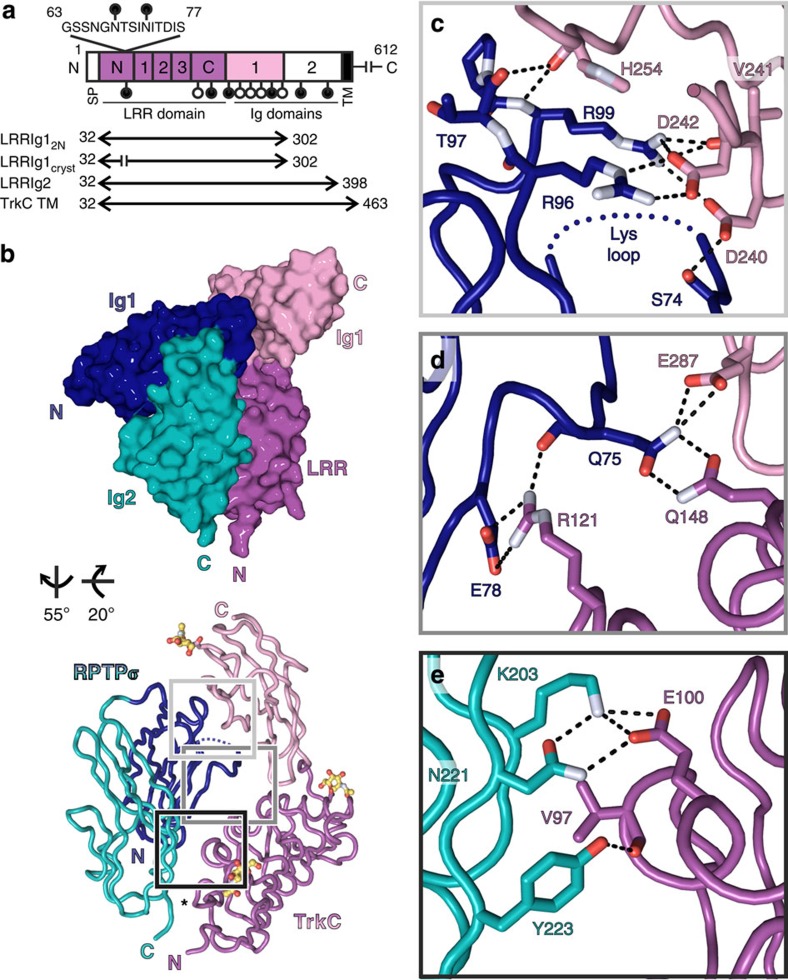
Trans-synaptic RPTPσ:TrkC complex crystal structure.(a) TrkCTK- (non-catalytic isoform) domain organization. LRR, leucine-rich repeat region (N, N-terminal cysteine-rich region; 1–3, leucine-rich repeats; C, C-terminal cysteine-rich region). Putative N-linked glycosylation sites, lollipops; filled lollipops remain in LRRIg1cryst construct. (b) Space-filled and tube representations of chicken RPTPσ Ig1–2:TrkC LRRIg1cryst crystal structure. N-linked glycans in atom representation. Disordered RPTPσ Lys-loop, blue dotted line; TrkC LRRIg1cryst amino-acid residue 62–78 junction, asterisk. (c–e) Detailed view of bonding interactions at RPTPσ:TrkC interface for binding sites 1–3. Corresponding electron density is illustrated in Supplementary Fig. 7. Potential electrostatic and hydrogen bonds, black dashed lines; oxygen atoms, red; nitrogen atoms, bluewhite.